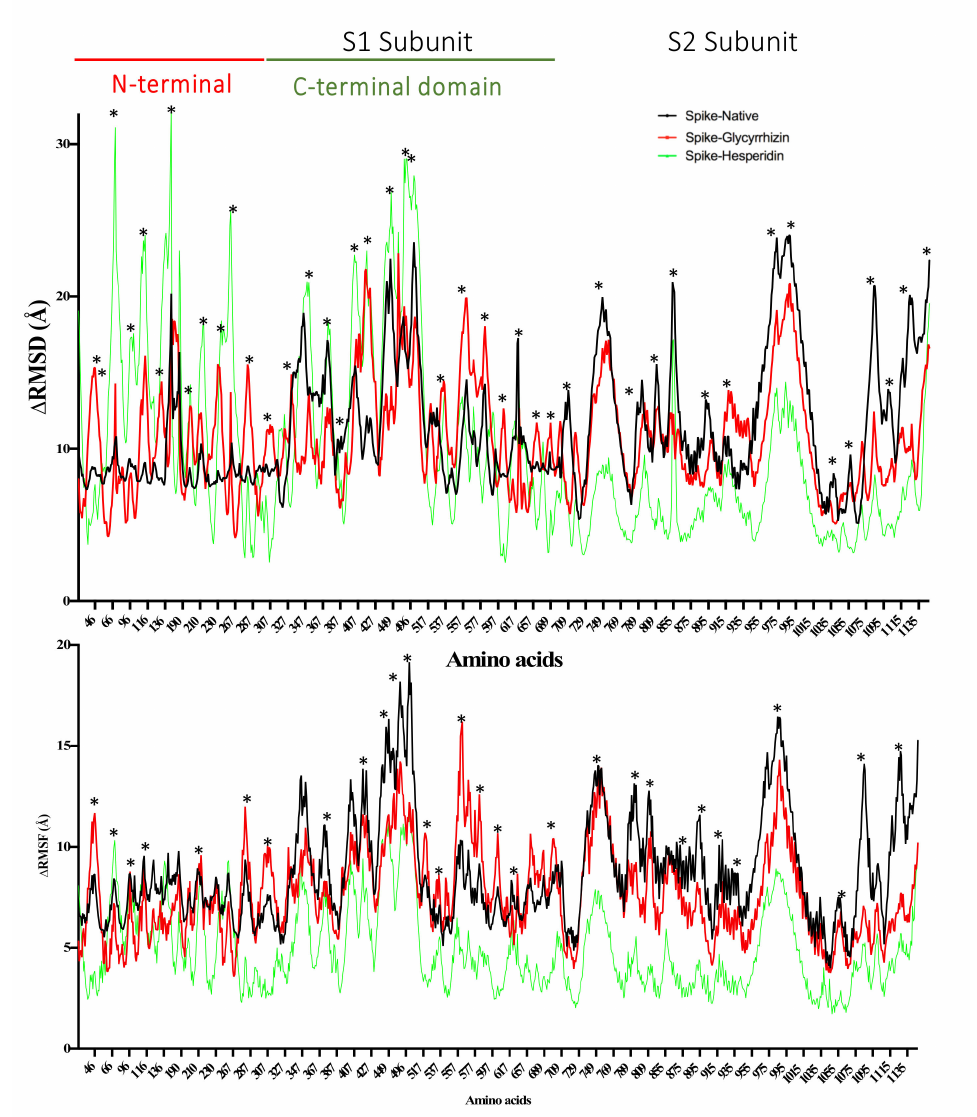
Figure 9. RMSD and RMSF calculated from 30 ns molecular dynamics simulation of Glycyrrhizin (red) and Hesperidin (green) in complex with SARS-CoV-2 spike protein (closed state). The residues with dynamic RMSD and RMSF are mentioned with